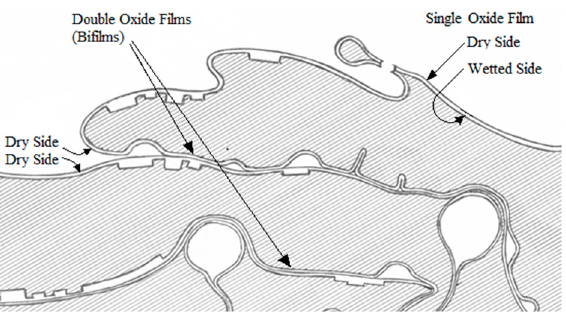
Figure 1. Turbulence in the liquid, causing entrainment of the surface oxide creating bifilms and bubbles.